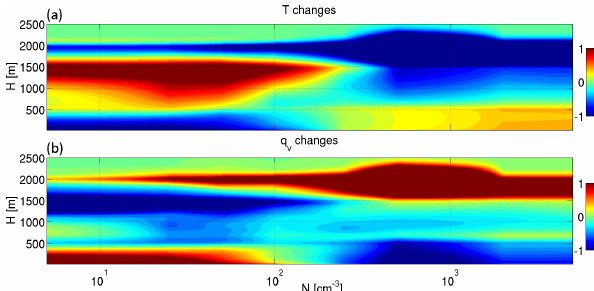
Figure 5. Total change, during 16h of simulation in the tempera- ture (K; a ) and water vapor content (gkg − 1 ; b ) domain mean ver- tical profiles as a function of the aerosol concentration used in the simulation.